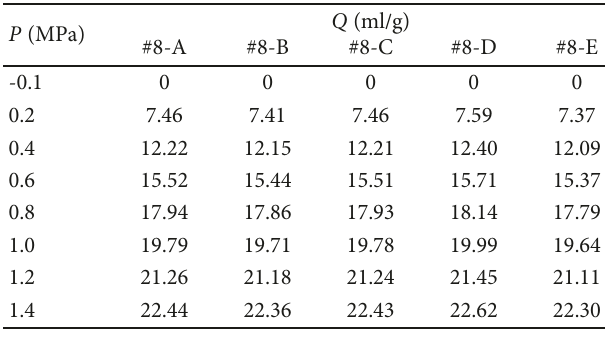
Table 2: Gas adsorption capacity of coal samples under di ff erent gas pressure conditions.